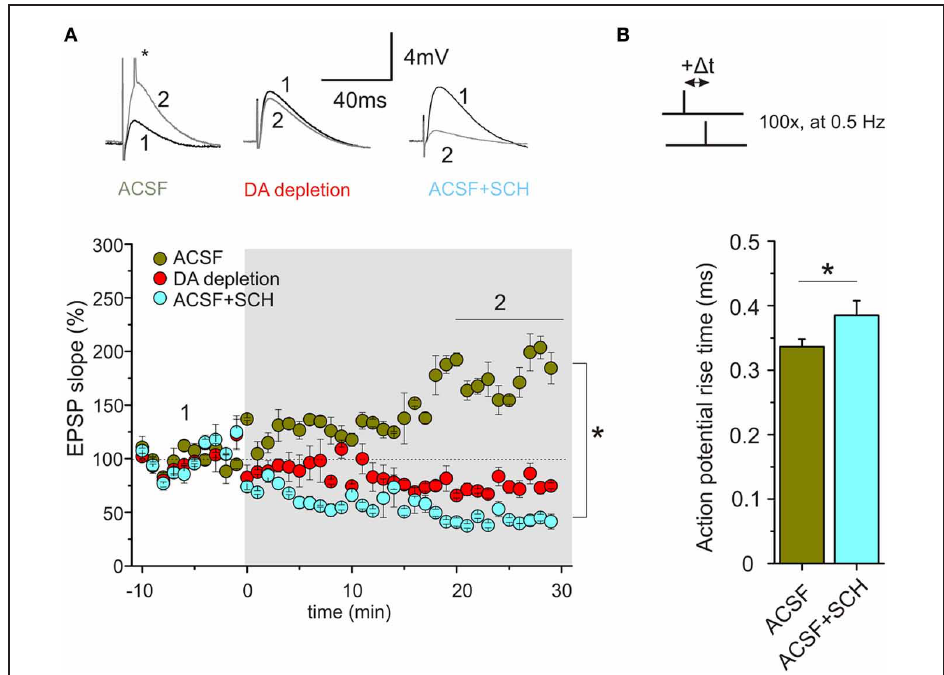
FIGURE 2 | Endogenous DA regulates STDP in CA1 of hippocampal slices via D1R signaling. (A) Bath application of the specific D1R antagonist SCH23390 (10 μ M) or DA depletion by preparation in SUC media inhibit t-LTP. For experimental conditions see Figure 1 . Green symbols indicate average results for neurons of the ACSF group (ACSF), red symbols indicate results for DA depleted slices (DA depletion), and light blue symbols show results for neurons in ACSF prepared slices, treated with SCH23390 ( + 10 μ M SCH). Inset above shows original traces before and after STDP induction for the three different conditions (small asterisk: action potential truncated). (B) AP rise time is significantly longer upon application of SCH23390 compared to ACSF (* p < 0 .